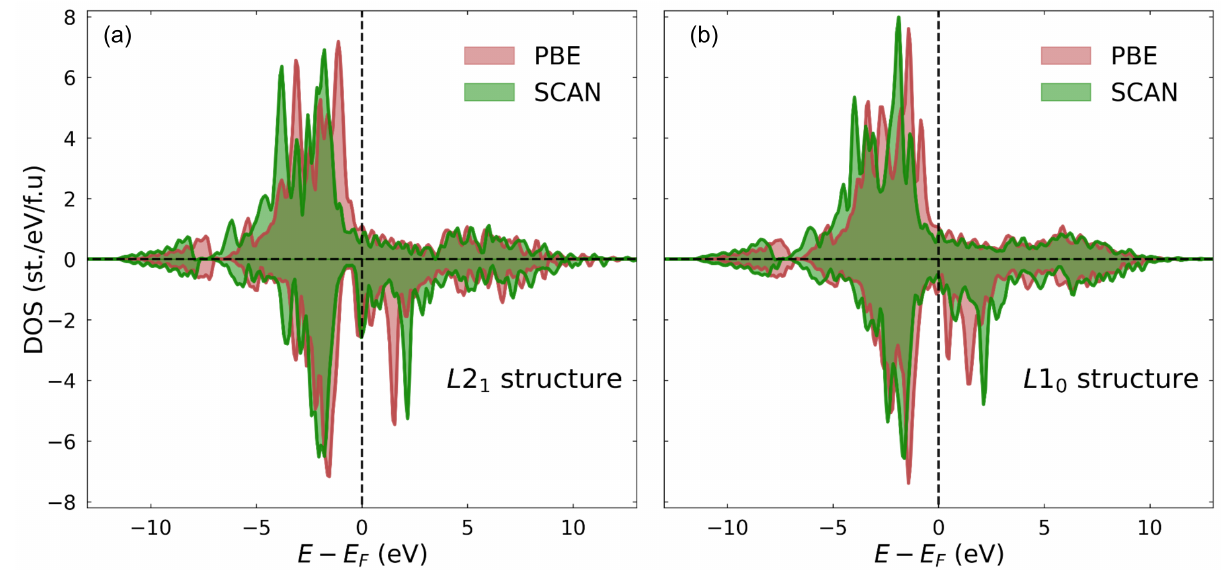
Figure 18. The total DOS calculated with PBE and SCAN for the ( a ) austenite and ( b ) martensite phases of Ni 2 MnGa